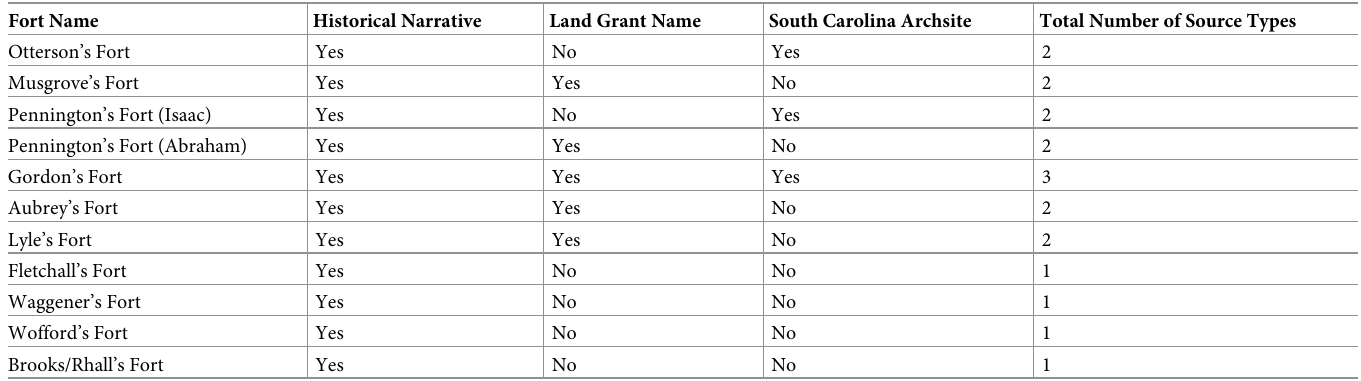
Table 1. Source material for georeferencing the Ango-Cherokee war period settler